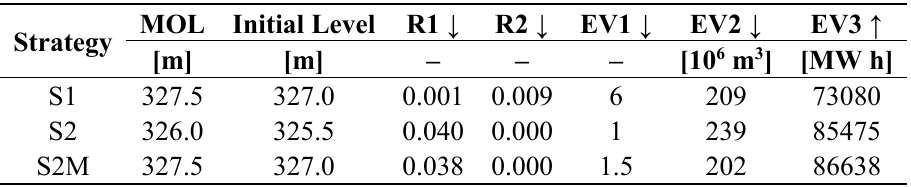
Table 3. Evaluation of performance of different